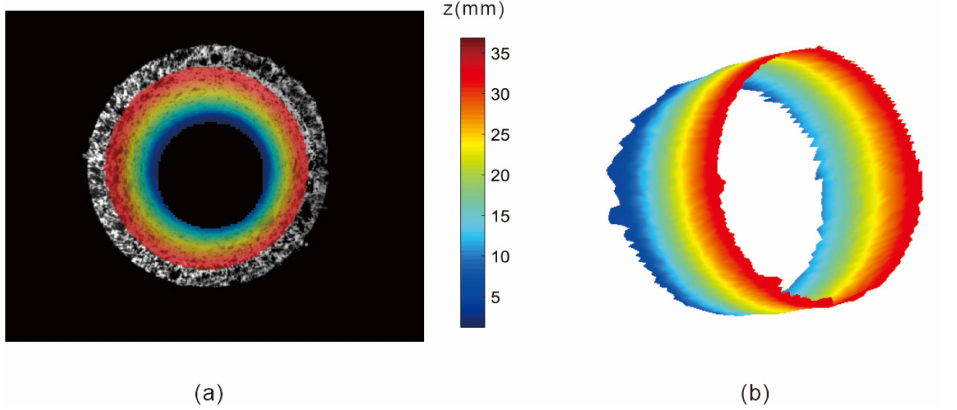
Figure 8. ( a ) Real calculation area; ( b ) Three-dimensional outline of the inner surface.